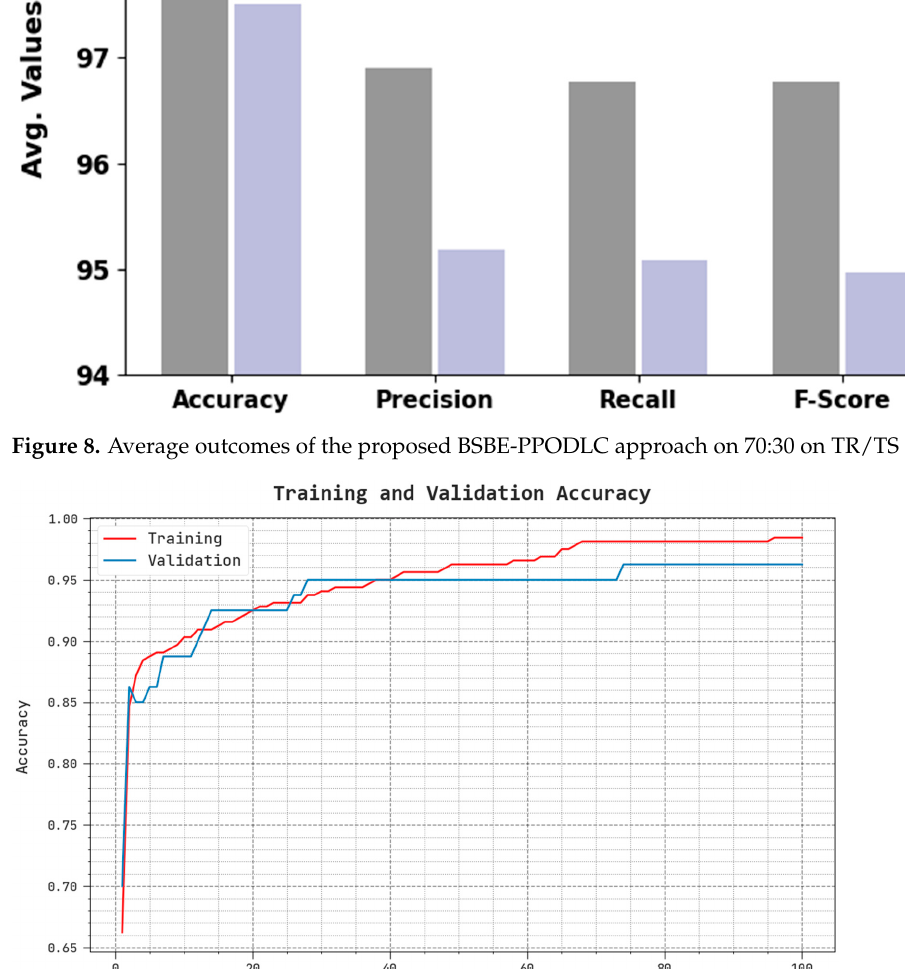
Figure 9. TACC and VACC outcomes of the BSBE-PPODLC approach.